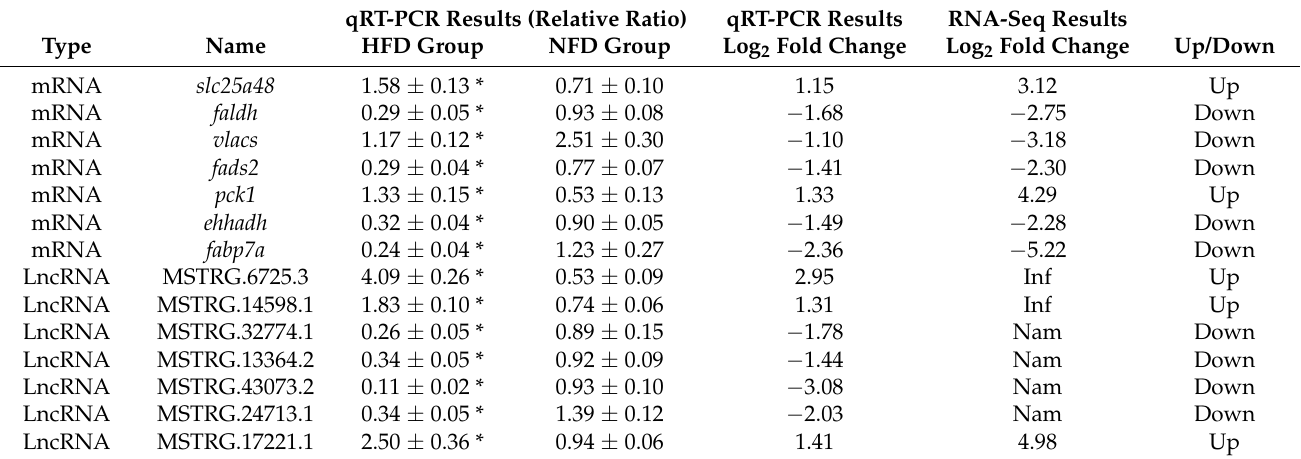
Table 3. Comparison of qRT-PCR and RNA-seq results of 14 candidates (7 lncRNAs and 7 mRNAs). qRT-PCR Results (Relative